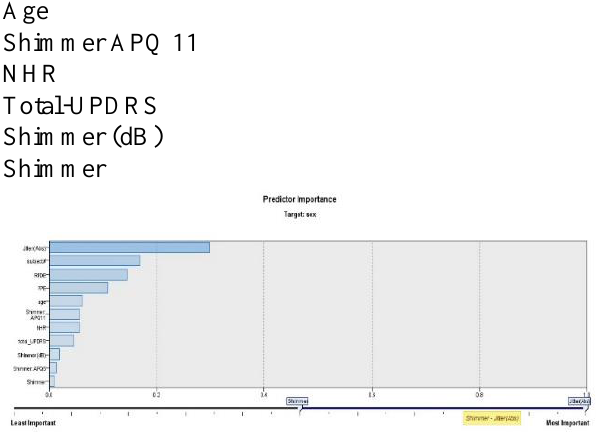
Figure 4. Predictor importance in SVM algorithm.